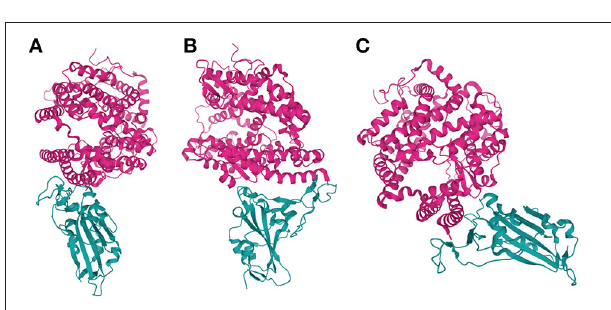
FIGURE 2 | SARS-CoV-2S interfacing with ACE2. Various orientations of an X-ray crystallography-derived cartoon representation of the Spike protein S1 subunit of SARS-CoV-2 (cyan) bound to an extracellular portion of ACE2 (residues 1-597; pink). (B) Is a 90 ◦ anticlockwise rotation, along the z-axis, of (A) , while (C) is angled to highlight the shape of the binding interface between ACE2 and SARS-CoV-2S, ∼ 90 ◦ clockwise along the z-axis, and ∼ 45 ◦ counter-clockwise along the x-axis, relative to A. Figure was created using *Mol. PDB ID: 6M0J, Crystal Structure of SARS-CoV-2 spike receptor-binding domain bound with ACE2 (97,